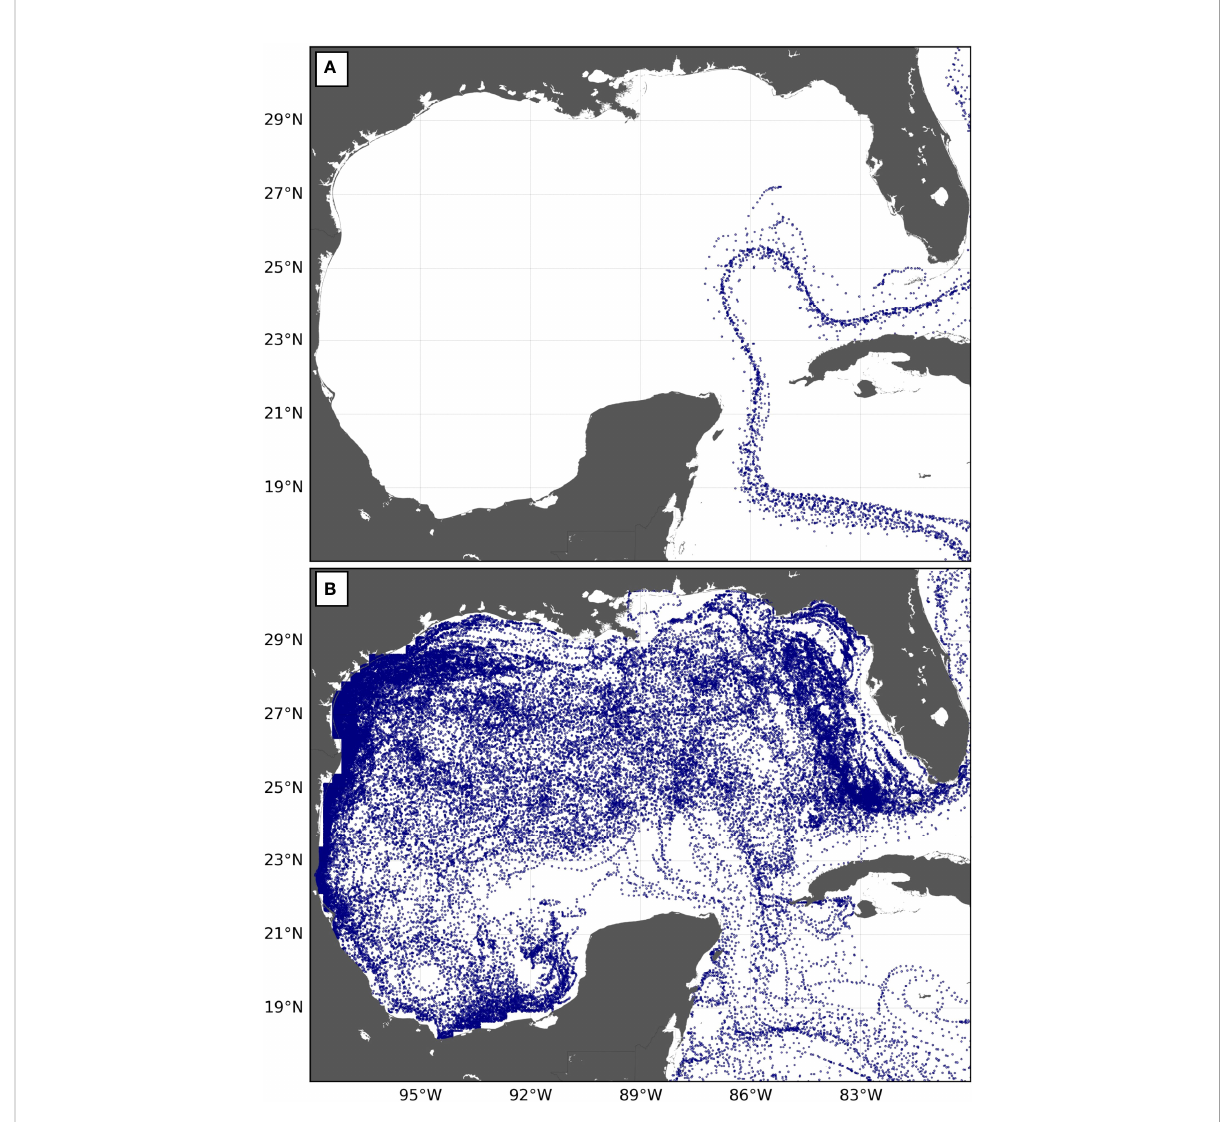
FIGURE 8 Trajectories in the GoM of 50 simulated WCA juvenile leatherbacks released off Chiriqui Beach in 2005 and entering the GoM (A) between 1 and 12 August 2005, at a time when the Loop Current follows its retracted “ entry to exit ” pathway, and (B) between 7 and 18 February 2006, when the Loop Current is shedding an